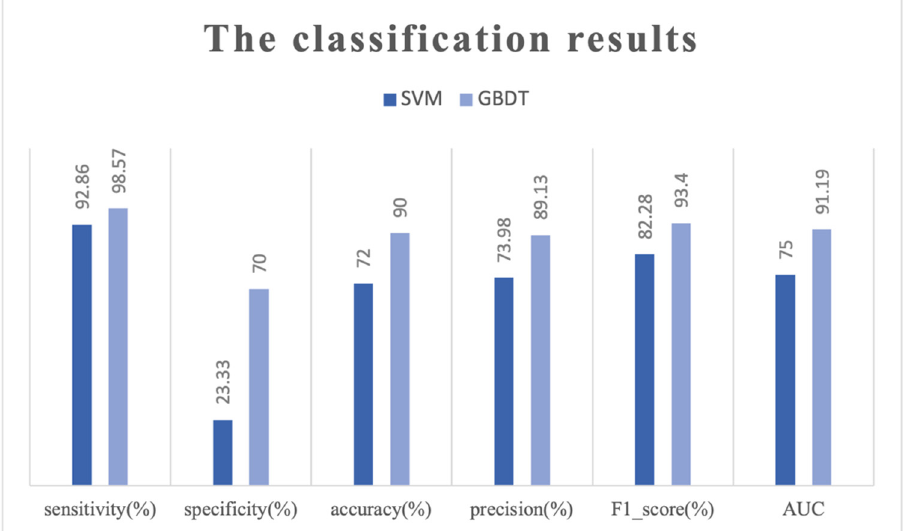
Figure 4. The histogram of the classification results of SVM and GBDT. Six criteria were used to evaluate the classifier model. Obviously, the classification performance of GBDT was better than SVM.